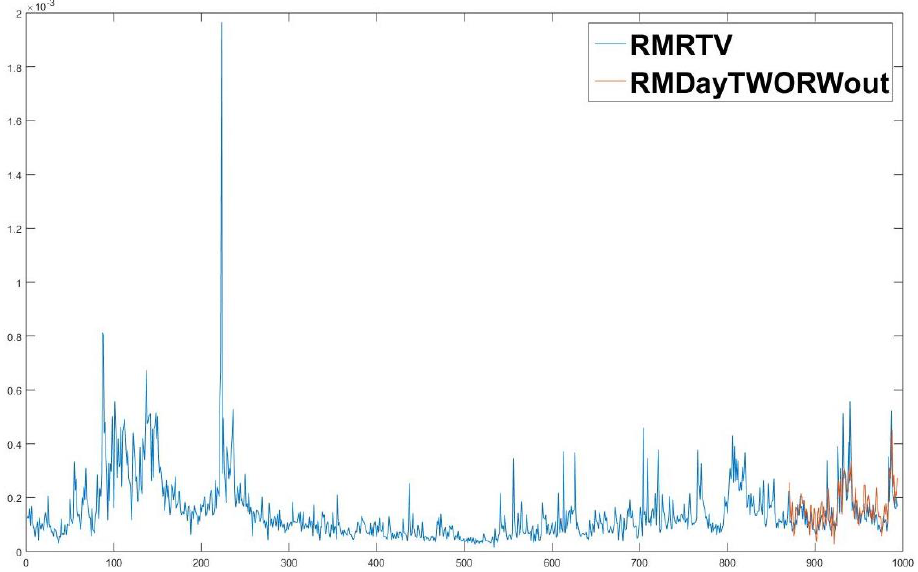
Figure 8. Model TWORW-RTV Forecast for RM(CZCE). The horizontal line is the timeline, and the perpendicular line is the volatility estimator. The forecasted period is the last 124 days. The actual values are represented by the blue line, while the forecasted values are represented by the orange line. The forecasted values are more volatile than the actual values, since the forecasted model is constructed by a random